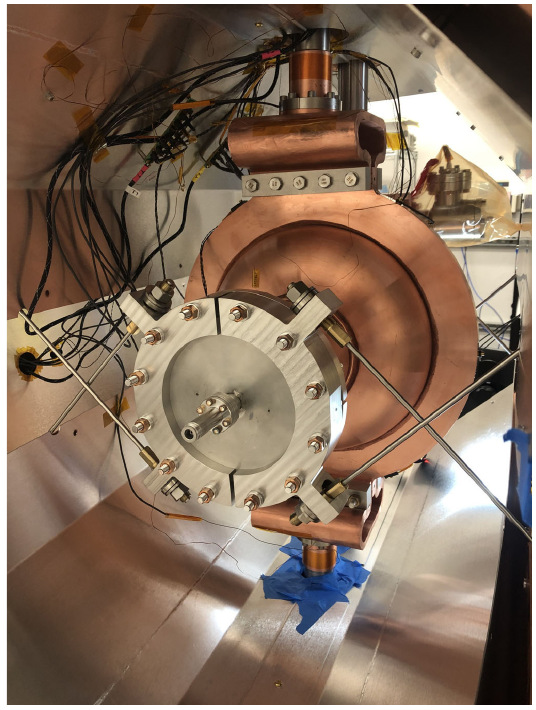
FIG. 21. Picture of the prototype cavity being assembled in the HTC at General